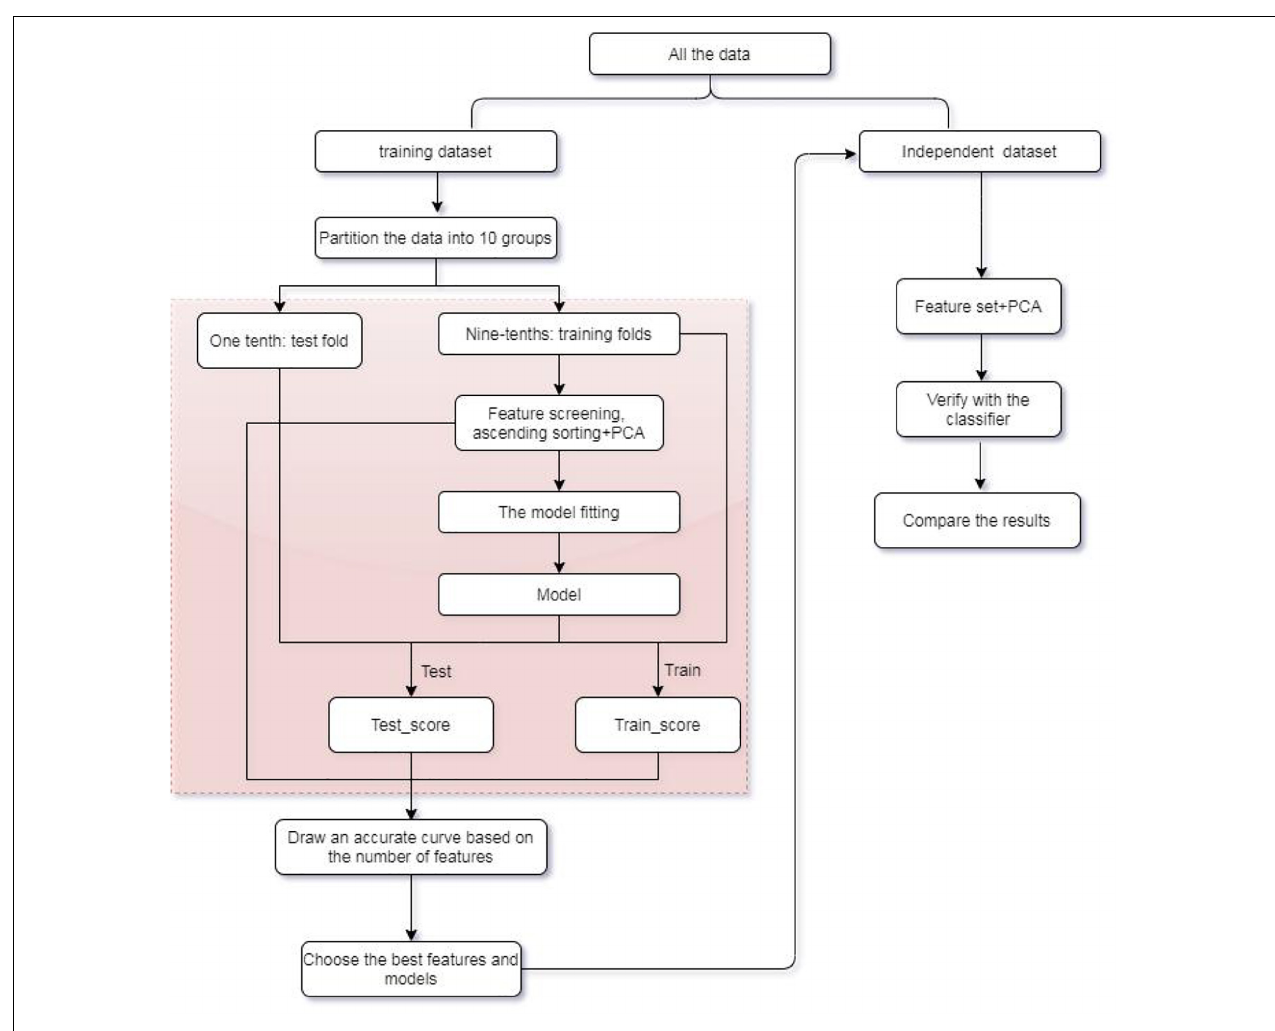
FIGURE 1 | Flow chart of the